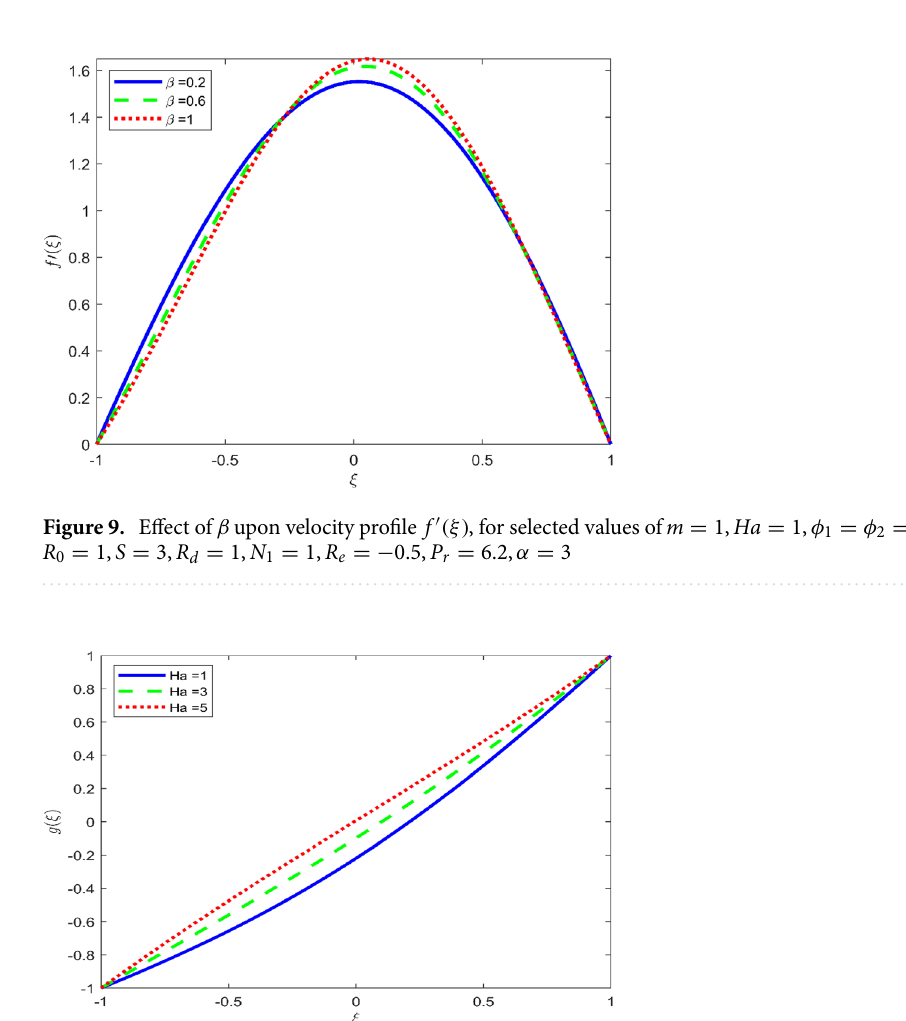
Figure 8. Effect of β upon velocity profile H (ξ) , for selected values of m 1, S 3, R 1, N 1 1, R R 0 e = − d = = = =